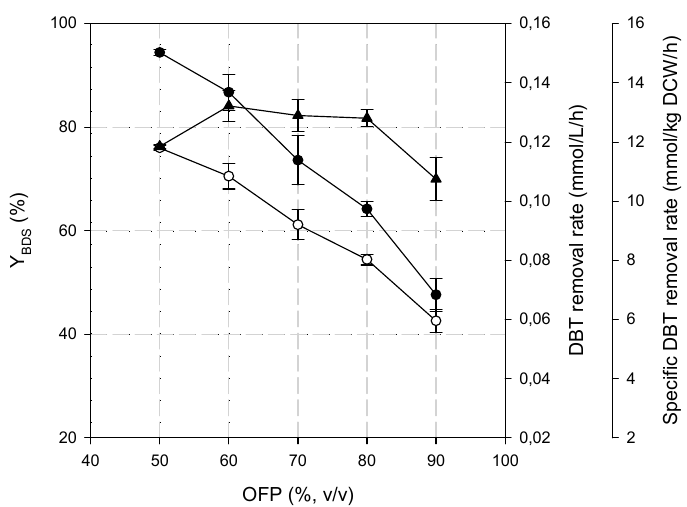
Figure 6. Effect of hydrocarbon–aqueous phase ratio on desulfurization of DBT by resting cells of R. erythropolis IGTS8. Symbols : ( λ ) Y BDS (%), ( ◯ ) DBT removal rate (mmol/L/h), and ( π ) specific BDT removal rate (mmol/kg DCW/h). The volumes of the hydrocarbon and aqueous phases were varied by keeping the total reaction mixture volume constant.